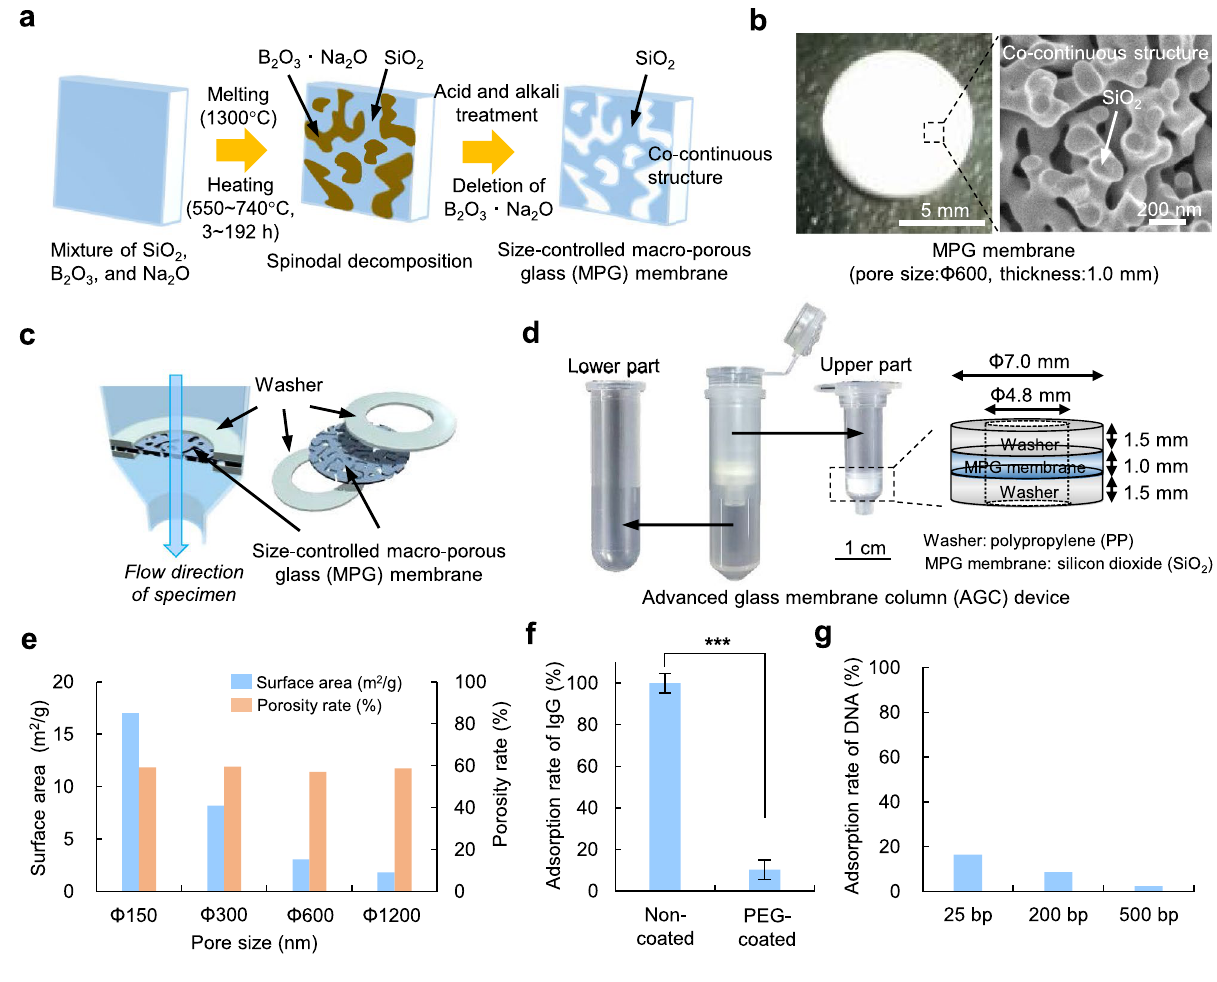
Figure 1. Fabrication of the AGC device. ( a ) The production process for producing a size-controlled macro- porous glass (MPG) membrane. ( b ) A photograph and SEM image of the MPG membrane. ( c , d ) An image ( c ) and photograph ( d ) of the advanced glass membrane column (AGC) device. The MPG membrane in the AGC device was sandwiched by washers. The AGC device was composed of two parts (upper part: EV collection, lower part: supernatant collection). ( e ) The surface area (m 2 /g) and porosity rate (%) of the membranes (outside diameter: 7.0 mm, thickness: 1.0 mm, pore size: Φ150, Φ300, Φ600, Φ1200 nm). ( f ) The adsorption rate (%) of IgG in the non-PEG coated and PEG coated MPG membranes. ( g ) The adsorption rate (%) of dsDNA (25 bp, 200 bp, 500 bp) in the PEG coated MPG